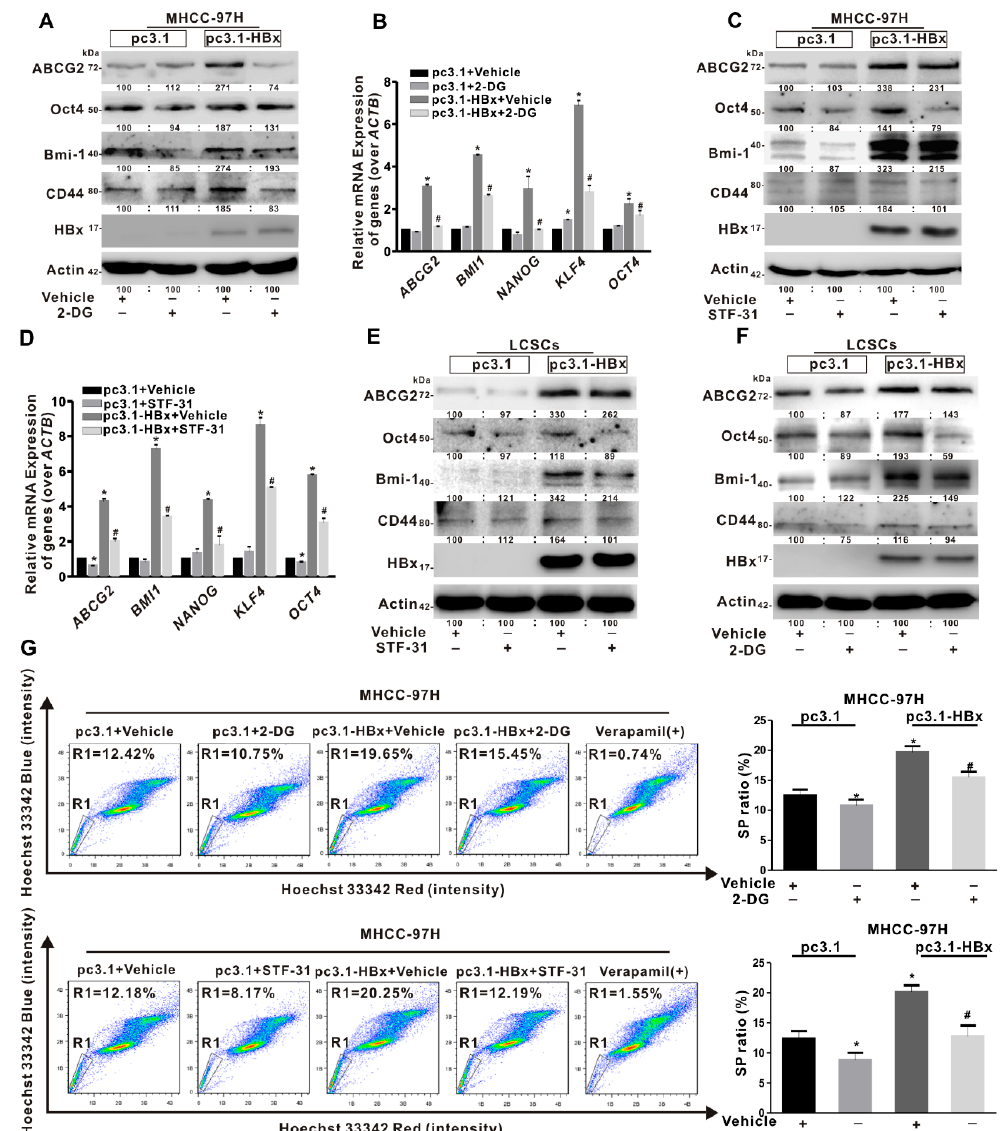
Figure 4. Glycolytic metabolism regulated cancer stemness of HBx-expressing MHCC-97H cells and LCSCs. MHCC-97H cells without or with HBx-expressing were transiently transfected with pcDNA3.1 or pcDNA3.1-HBx (1 μ g/mL) for 8 h, followed by treatment with 2-DG (4 μ mol/L) or STF-31 (8 μ mol/L) or not for another 24 h. ( A , B ) The expression levels of cancer stemness-related proteins ( A ) and the mRNA levels of cancer stemness-related genes ( B ) in HBx-expressing MHCC-97H cells treated with 2-DG or not. ( C , D ) The expression levels of cancer stemness-related proteins ( C ) and the mRNA levels of cancer stemness-related genes ( D ) in HBx-expressing MHCC-97H cells treated with STF-31 or not. The target gene transcription was normalized to ACTB . ( E , F ) LCSCs were enriched by sphere-formation assay in MHCC-97H cells. The expression levels of cancer stemness-related proteins in HBx-expressing sphere-formed LCSCs treated with STF-31 (E) or 2-DG (F) or not. The gray value of band was assessed by image-pro plus 6.0. The relative expression level was shown. ( G ) Percentage of the sorted SP cells (R1 gate) in HBx-expressing MHCC-97H treated with 2-DG (Upper) or STF-31 (Lower) or not were detected by FCM (Left). Quantitative results were shown in bar graph (Right). SP: side population. R1 gate represented SP cells. * P < 0.05 as compared with pc3.1+Vehicle group, # P < 0.05 as compared with pc3.1-HBx+Vehicle group. pc3.1: pcDNA3.1 transfection without HBx-expressing. pc3.1-HBx: pcDNA3.1-HBx transfection with HBx-expressing.